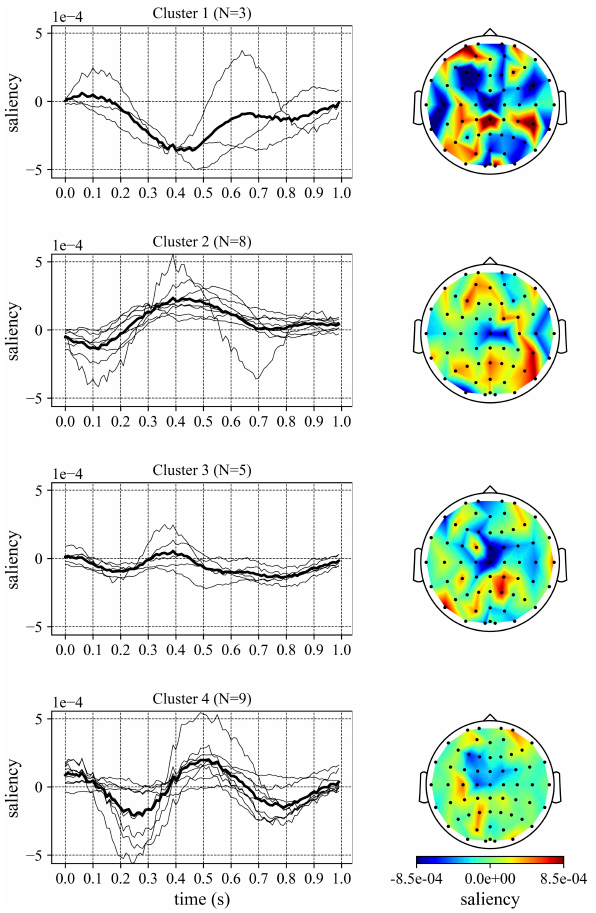
Fig. 9. Cluster analysis: distractor. For each cluster individuated by hierarchical agglomerative clustering, the left panel displays the tempo- ral cluster-specific saliency pattern (thick line) together with the temporal subject-specific saliency patterns (thin lines) defining each cluster, while the topological map on the right displays the spatial cluster-specific saliency pat-